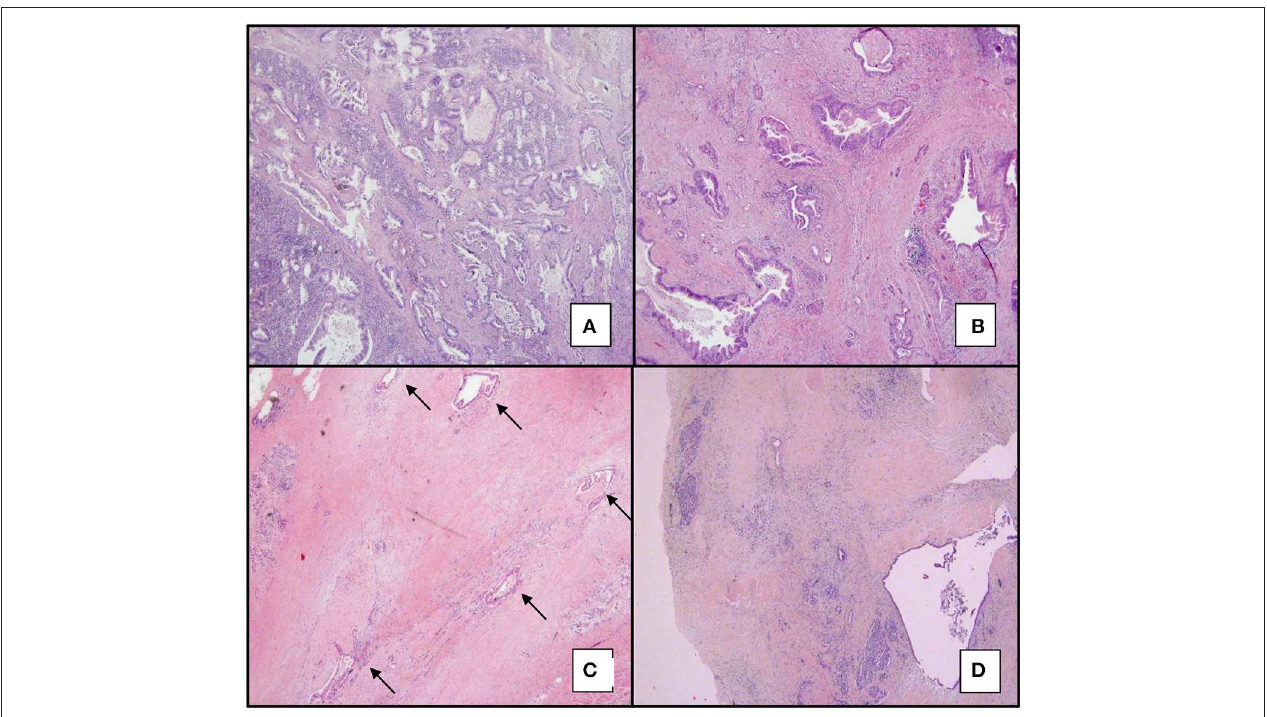
FIGURE 1 | iDworak TRG system applied to PCs. iDworak TRG system applied to PCs. (A) (4x): dominant tumor mass with poor fibrosis. (Grade 0). (B) (4x): dominant tumor mass with obvious fibrosis (Grade 1). (C) (4x): few tumor cells or groups (easy to find, Grade 2); arrows indicate neoplastic glands. (D) (4x and